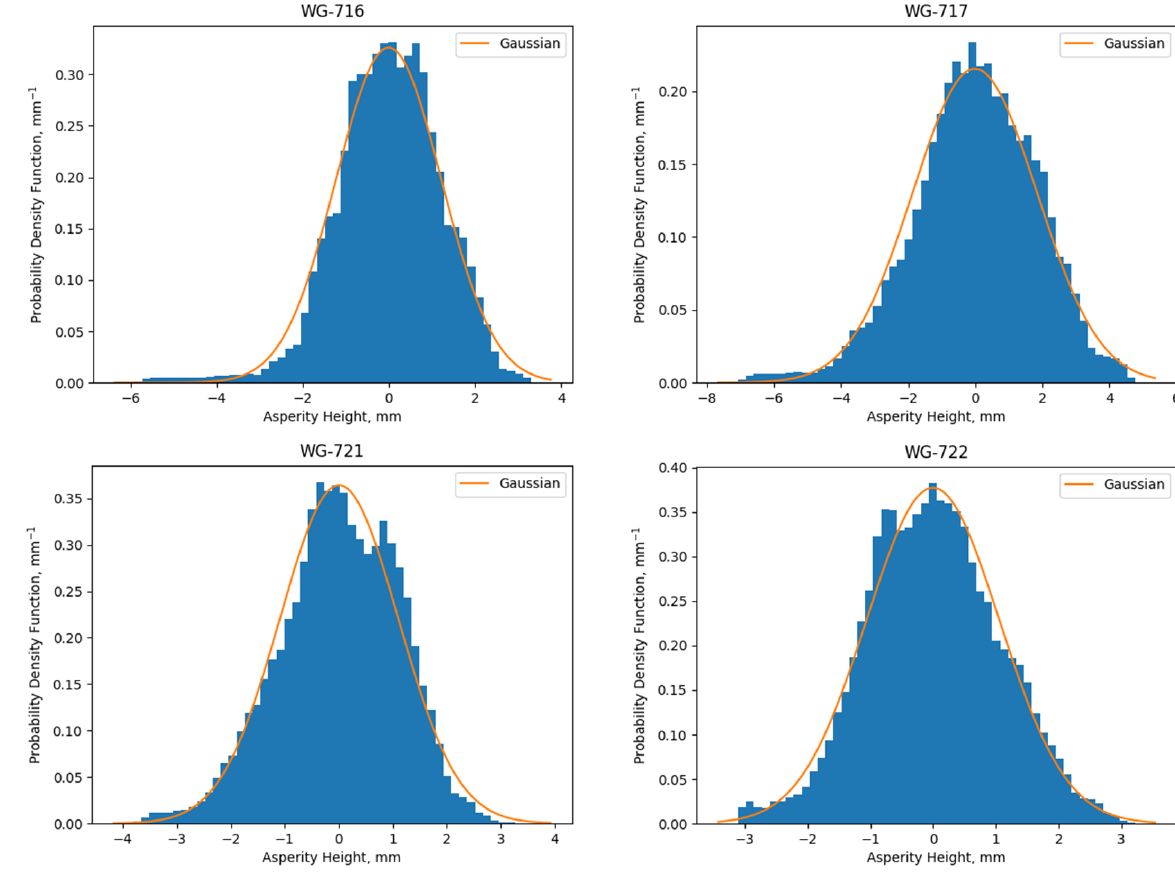
Figure 24. Histograms of asperity height (blue histogram) and Gaussian distribution of asperity heights of the measuring surface (orange line).